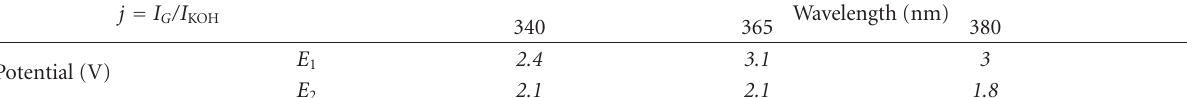
Table 1: I G /I KOH values obtained at the di ff erent wavelengths and at two di ff erent potentials.